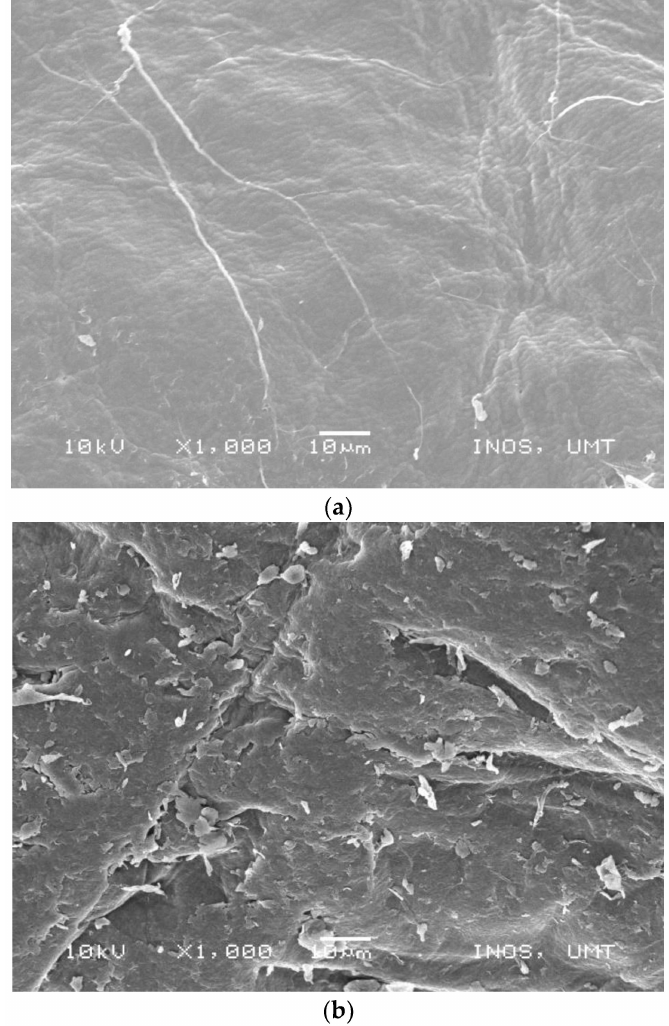
Figure 5. ( a ) SEM image of chitosan from carapace of M. rosenbergii . ( b ) SEM images of commercial